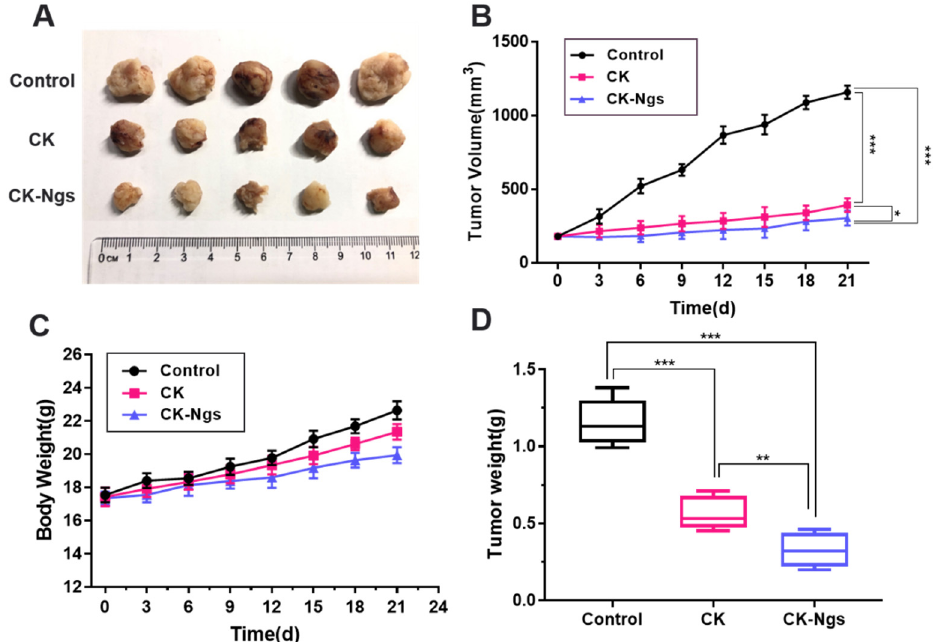
Figure 11. CK and CK-Ngs significantly inhibit the growth of A549 xenografts in vivo. ( A ) The image of A549 tumor-bearing nude mice in different administration groups. ( B ) The effects of different administration groups on tumor volume of nude mice bearing A549 tumor. ( C ) The effect of control, CK and CK-Ngs on body weight of nude mice. ( D ) The effect of different administration groups on tumor weight of A549 tumor-bearing nude mice. (* represents p < 0.05, ** represents p < 0.01, *** represents p < 0.001).